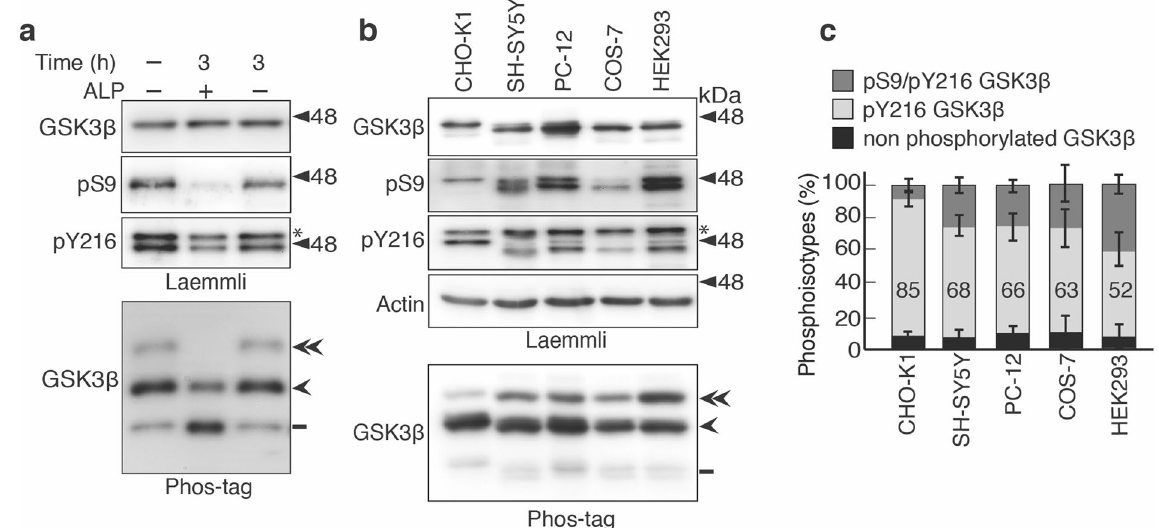
Figure 2. Phosphoisotypes of endogenous GSK3 β in various cell lines. ( a ) Dephosphorylation of endogenous GSK3 β with alkaline phosphatase (ALP). The CHO-K1 cell extract was incubated with 2.5 U/ml ALP for 3 h and was subjected to Laemmli’s (upper) and Phos-tag (lower) SDS-PAGE, followed by immunoblotting with anti-GSK3 β , anti-pS9 and anti-pY216 antibodies. In Phos-tag blot the double-arrowhead indicates Ser9/Tyr216 double phosphorylated GSK3 β , the arrowhead indicates Tyr216-phosphorylated GSK3 β , and the bar indicates nonphosphorylated GSK3 β . ( b ) Immunoblots showing the endogenous GSK3 β in cultured cell lines. The cell extracts of CHO-K1, SH-SY5Y, PC-12, COS-7 and HEK293 cells were subjected to Laemmli’s SDS-PAGE, followed by immunoblotting with anti-GSK3 β , anti-phospho-Ser9 (pS9) and anti-phospho-Tyr216 (pY216) antibodies. Actin was used as the loading control. An asterisk in the pY216 blot indicates GSK3 α . Phos-tag immunoblot of endogenous GSK3 β with anti- GSK3 β is shown in the bottom panel. The labeling of three bands in Phos-tag is as in ( a ). ( c ) Quantification of the GSK3 β phosphoisotypes: the upper dark gray section represents phospho-Ser9/phospho-Tyr216, the middle light gray section represents phospho-Tyr216, and the lower black section represents nonphosphorylated GSK3 β . The percentages of phospho-Tyr216 are indicated (means ± s.e.m. n = 3). Uncropped immunoblots after Laemmli’s and Phos-tag SDS-PAGE are provided in Supplementary Fig.